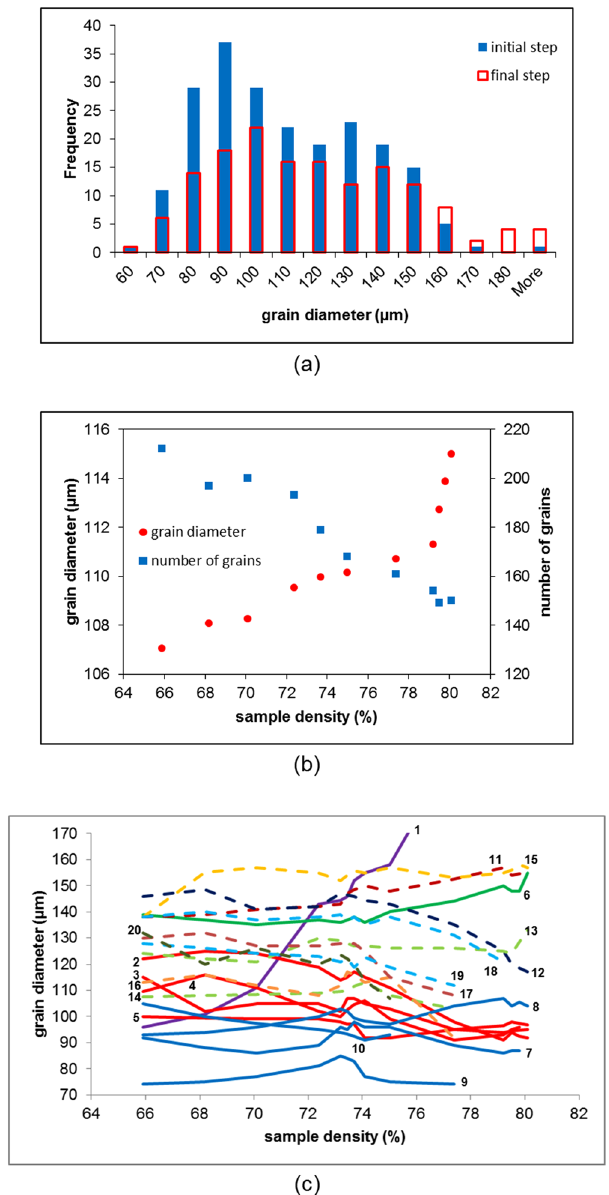
Figure 7. Quantification of grain growth and shrinkage. ( a ) Histograms showing grain diameter distributions at the initial and final sintering steps. ( b ) Showing both the average grain diameter and the number of grains through the sintering process, as a function of sample density. ( c ) Showing grain diameter profiles, as a function of sample density, for each of the grains in the local RoI of Fig. 6. The numbers correspond to the number labels indicated on the image of step1 in Fig. 6. Profiles with the same line colour correspond to grains within the same particle. Note: The profile for grain 1 is shown only up to 76% sample density – this grain continues to grow through to 80% sample density, reaching a size of approximately 310 µ